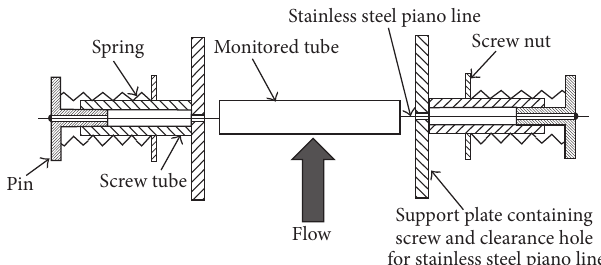
Figure 2: Schematic of the installation of the monitored tube.